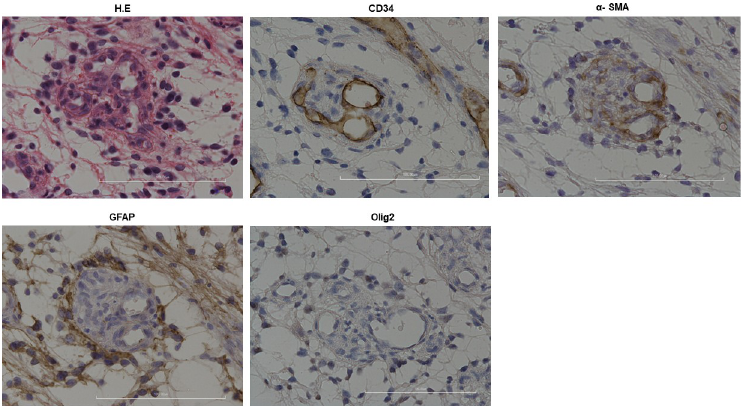
Fig 2. Histopathological findings of MVP in PA. H & E staining: MVP exhibiting a glomerular structure. CD34: Inner layer of MVP was stained against this marker. α -SMA: Cellular components of MVP were stained diffusely against this marker. GFAP and Olig2: No cellular components of MVP were stained against these markers. Original magnification: 20x. Scale bar: 100 μ